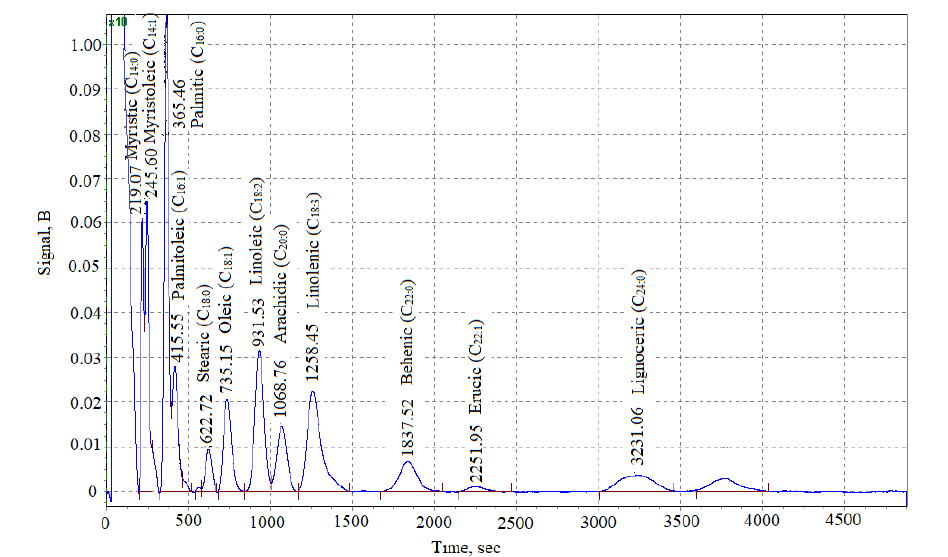
Fig. 3. Gas chromatogram of fatty acid composition in a lipophilic fraction of rye stalks (Khamarka variety)